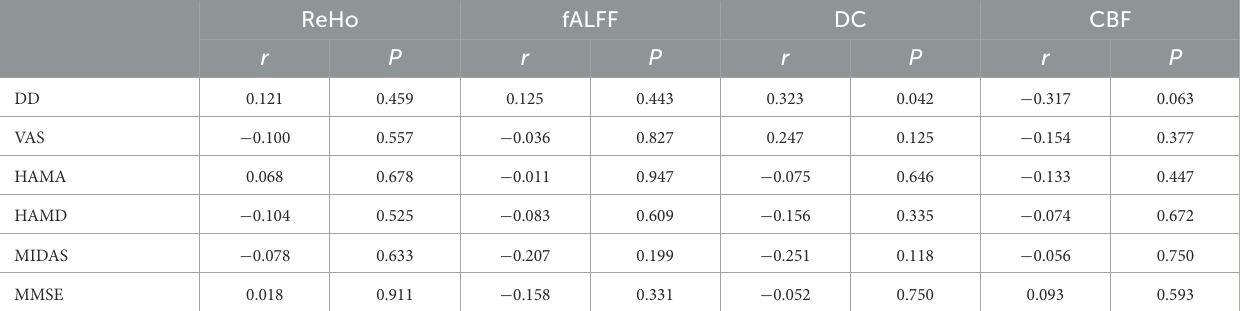
TABLE 3 Correlation between the resting-state fMRI variables extracted from the brain regions with altered NVC and the clinical characteristics in MOH.